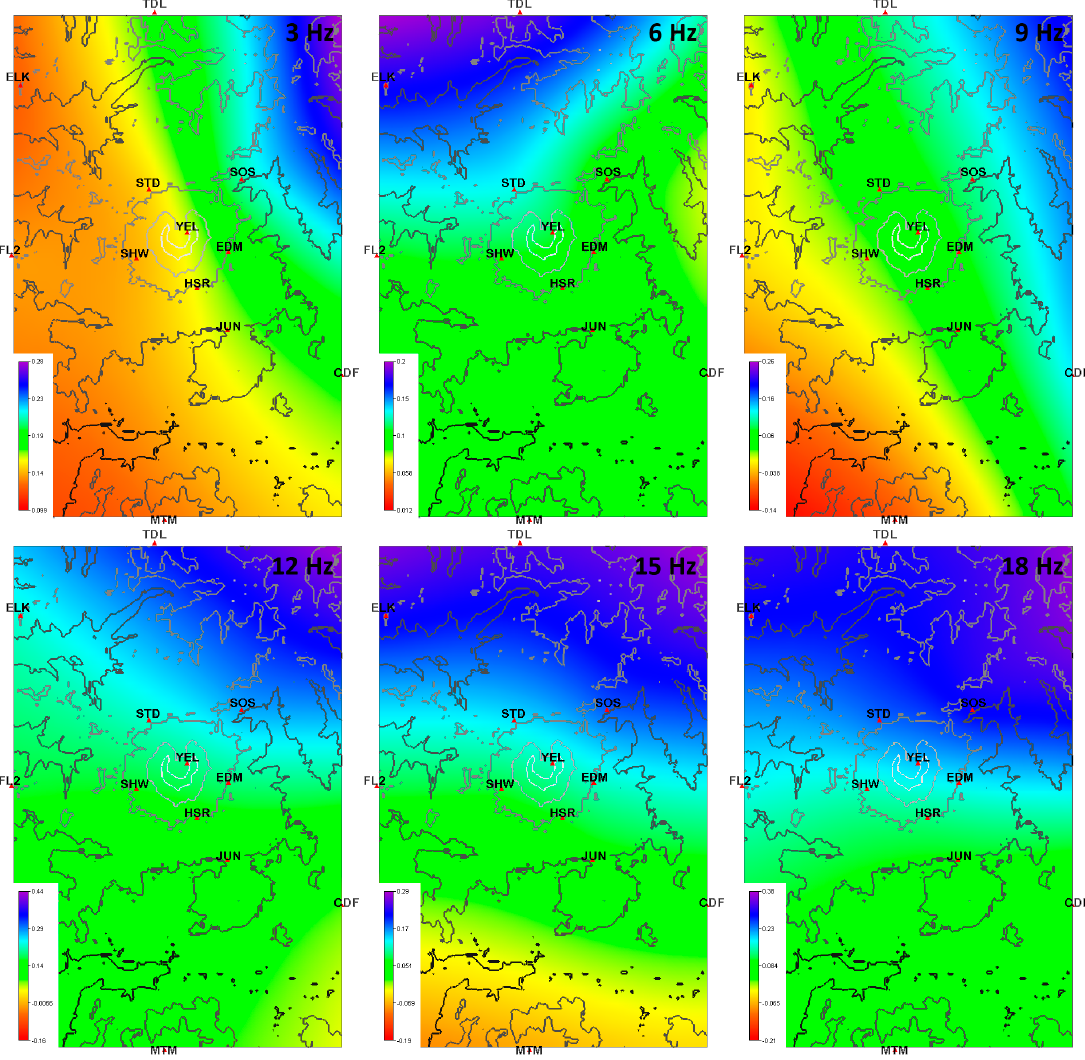
Figure 13. Attenuation (1/s) mapping using a local polynomial method. As with Figure 12, results correlate with peak delay times but show a strong dependence on large scale regional trends.